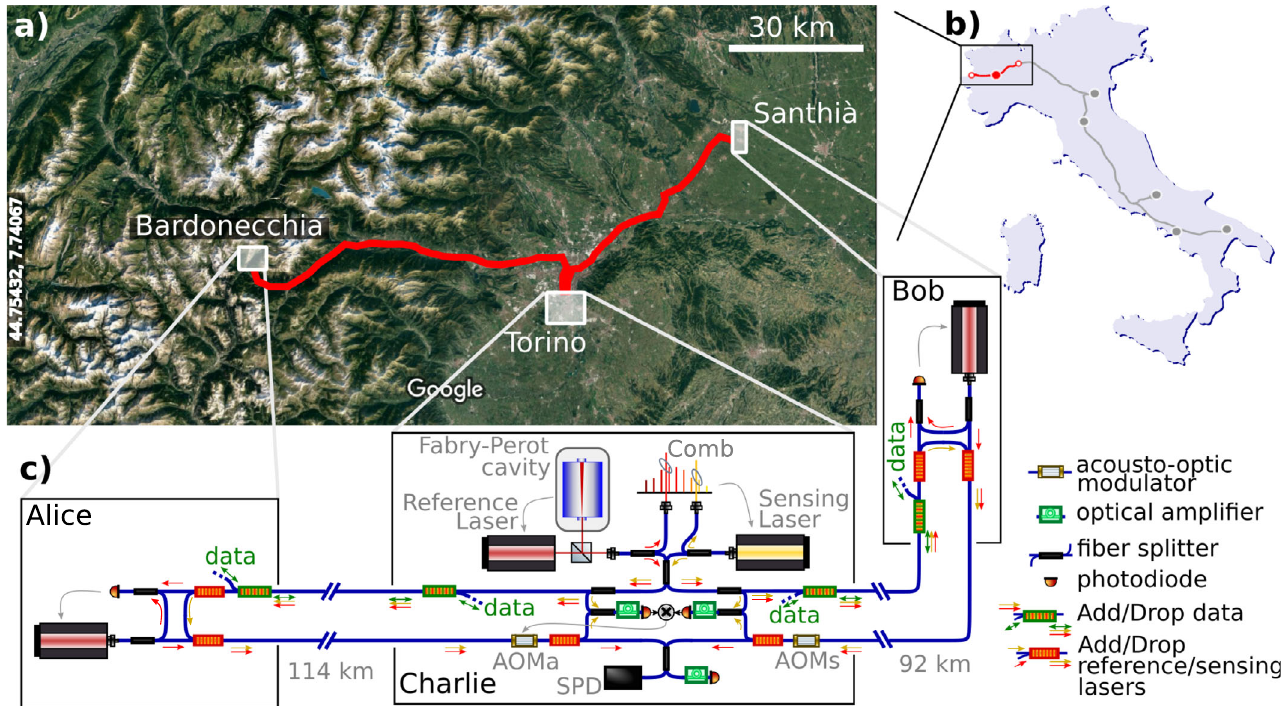
Fig. 2 Map and experimental set-up. a The testbed layout, with the Charlie node located at INRIM (Torino) and the Alice and Bob nodes in shelters of the telecom network in Bardonecchia and Santhià (Imagery © 2020 Landsat/Copernicus, Imagery © 2020 TerraMetrics, Map data © 2020). Latitude and longitude are indicated on the left edge. b A sketch of the Italian Quantum Backbone, with the spans used in this experiment colored in red and the red- fi lled (empty) circles representing Charlie (Alice and Bob). c The experimental setup. The reference laser in Charlie is stabilized to a high- fi nesse cavity and the sensing laser is phase-locked to it using an optical comb. They are combined and injected in the service fi bers (the uppermost ones) together with bidirectional data signals using wavelength division multiplexers. In Alice and Bob, the reference and sensing lasers are separated using the same devices. We detect the beat between the incoming reference laser and the local QKD lasers and phase-lock the two. The QKD lasers are then recombined with the sensing laser and sent to Charlie on dedicated fi bers (the lowermost ones). Upon recombination, the QKD lasers interfere on a photodiode when performing experiments in the classical regime, and on a single photon detector (SPD) in the photon-counting regime, also used to detect background photons. The fi ber noise is detected by interfering the local sensing laser with return light from each arm. The two beatnotes are detected on separate photodiodes and phase-compared in the RF domain. The resulting signal is integrated in a proportional-integral analog feedback loop and applied to the driving frequency of the acousto-optic modulator AOMa, which in turns adjusts the optical phase of the travelling beams to stabilize the interferometer. Because both the sensing and QKD lasers travel through AOMa, the fi ber noise is suppressed from the QKD interference signal as well. AOMs is a fi xed frequency shifter, used to enable the self-heterodyne beatnote detection on Bob ’ s